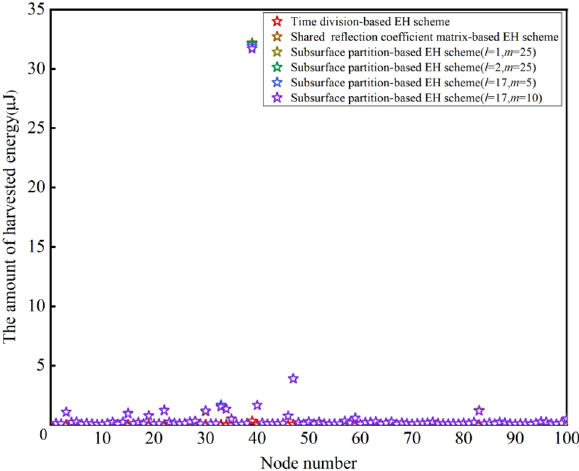
Figure 4. Comparison results of the amount of energy harvested by each CRSNs